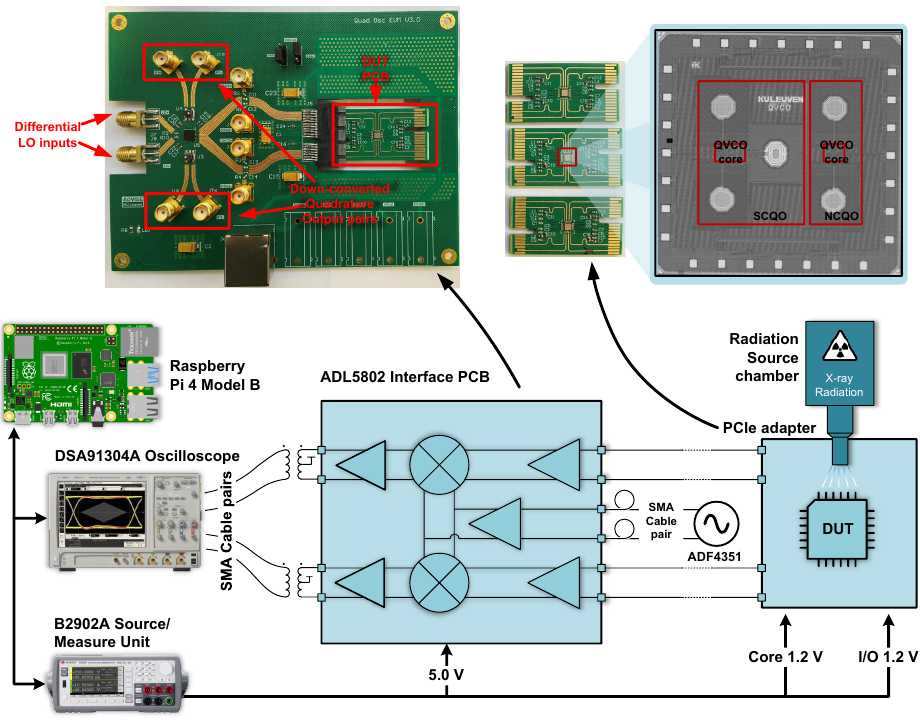
Figure 7. Overview of test setup for radiation assessment of QVCOs and the micrograph of the die (2 mm × 2 mm) in the top right